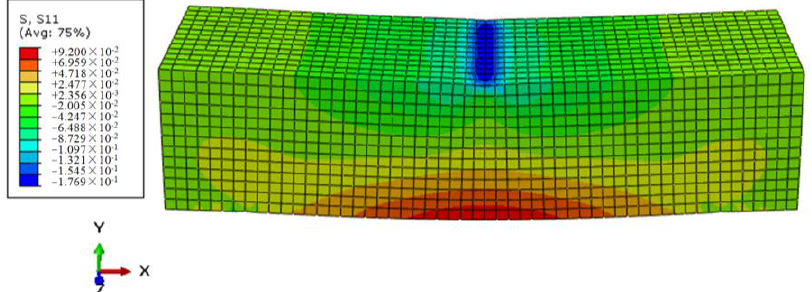
Figure 5. Stress contours of the control under a constant load.